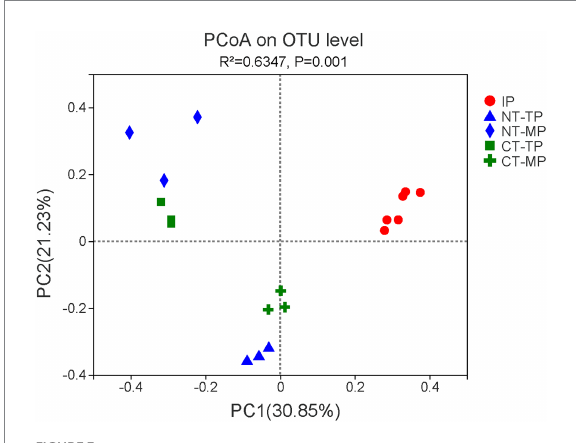
FIGURE 3 The overall distribution pattern of operational taxonomic unit (OTU)-based transconjugant community dissimilarity in the normal thermophilic (NT) and continuous thermophilic composting (CT). Principal coordinate analysis (PCoA) of beta diversity based on the Bray–Curtis distance analysis of the OTU level. IP, TP, and MP represent the initial, thermophilic, and mature phases,